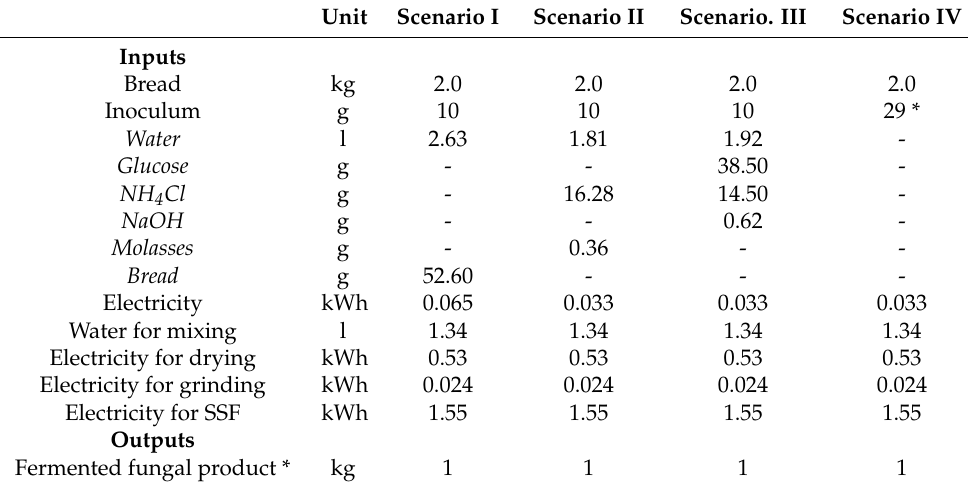
Table 1. Inventory analysis for the different scenarios for the production of the fermented fungal product per functional unit. The indented substances in italic refer to the inputs related to the production of the fungal biomass (inoculum) used for the